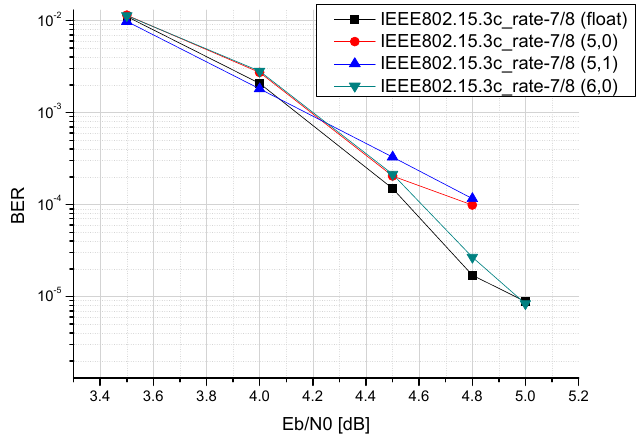
Figure 15. Fixed-point simulation in IEEE 802.11ad R = 13/16.